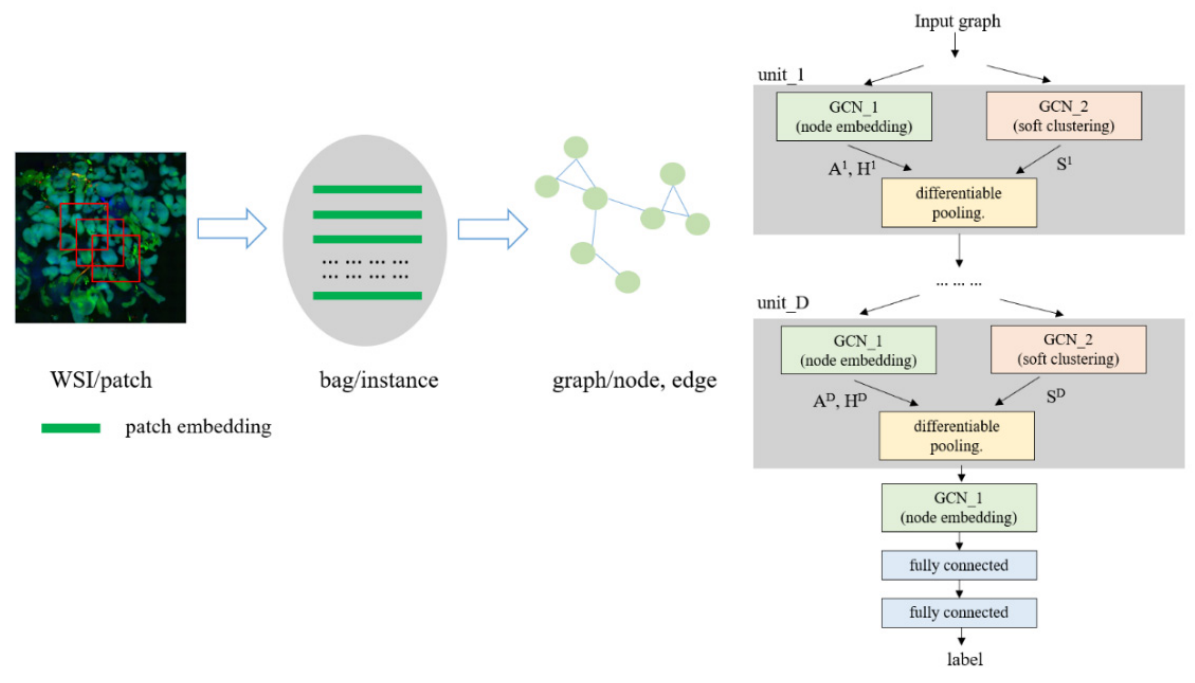
Figure 4. The flowchart of the proposed method.